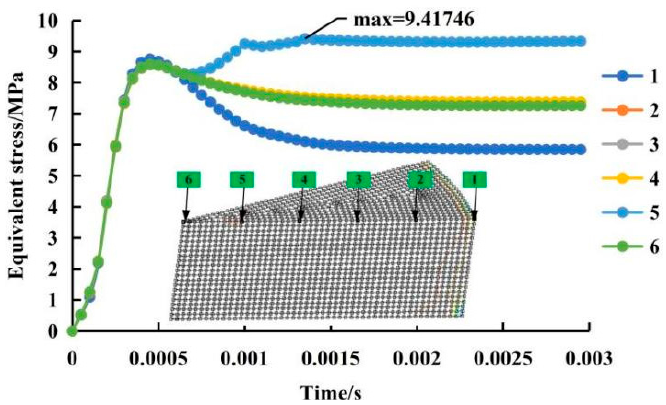
Figure 12. The stress distribution on the bar in the radial direction.